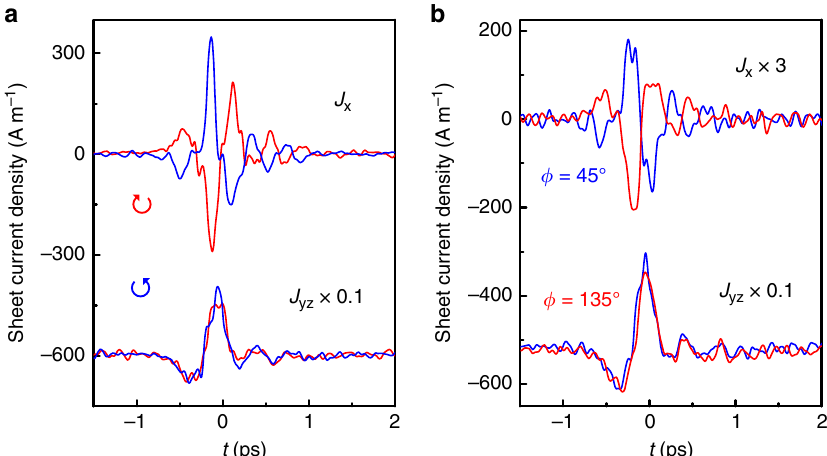
Fig. 6 Extracted sheet photocurrent densities J x ( t ) and J yz ( t ). a and b are for different circular and linear pump polarization at 800 nm, respectively. Curves are offset for